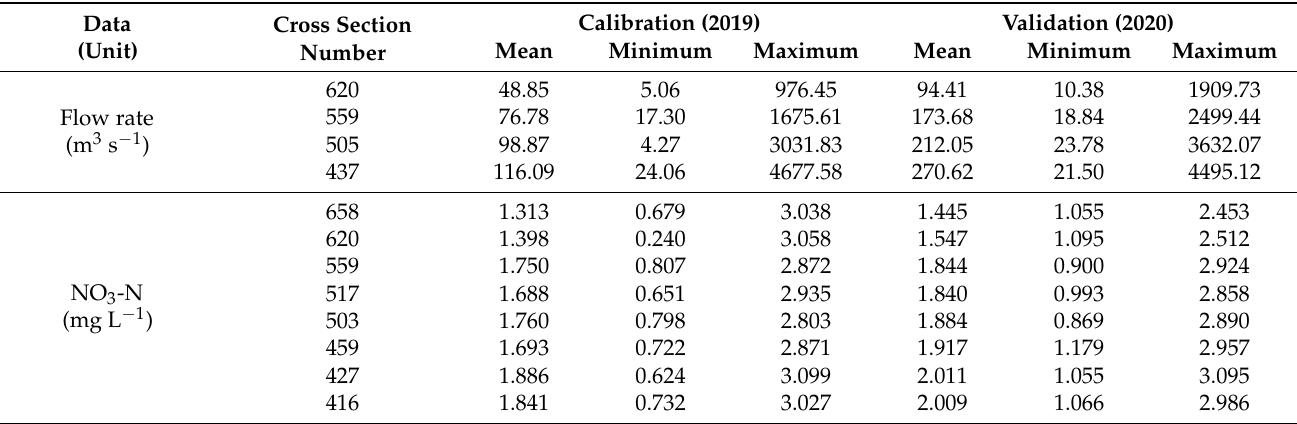
Table 3. Mean, minimum, and maximum values of the observational data (flow rate and NO 3 -N) in the cross sections for model calibration (2019) and validation